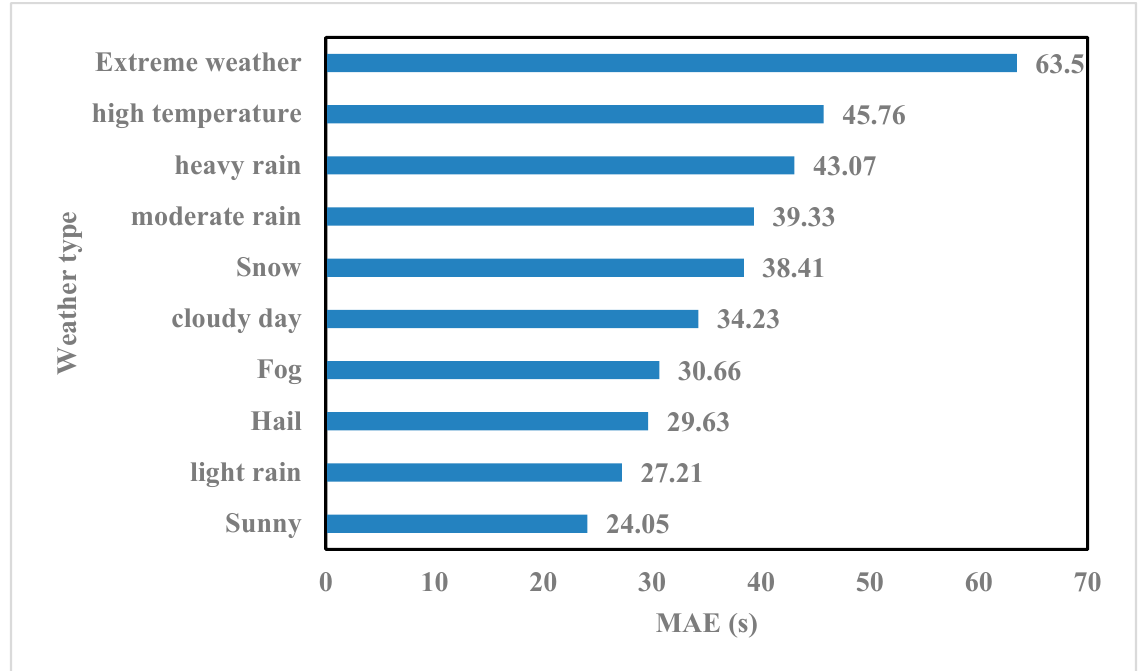
Figure 10. Prediction effect of different weather features.